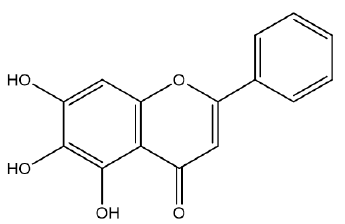
Figure 1. The chemical structure of baicalein.